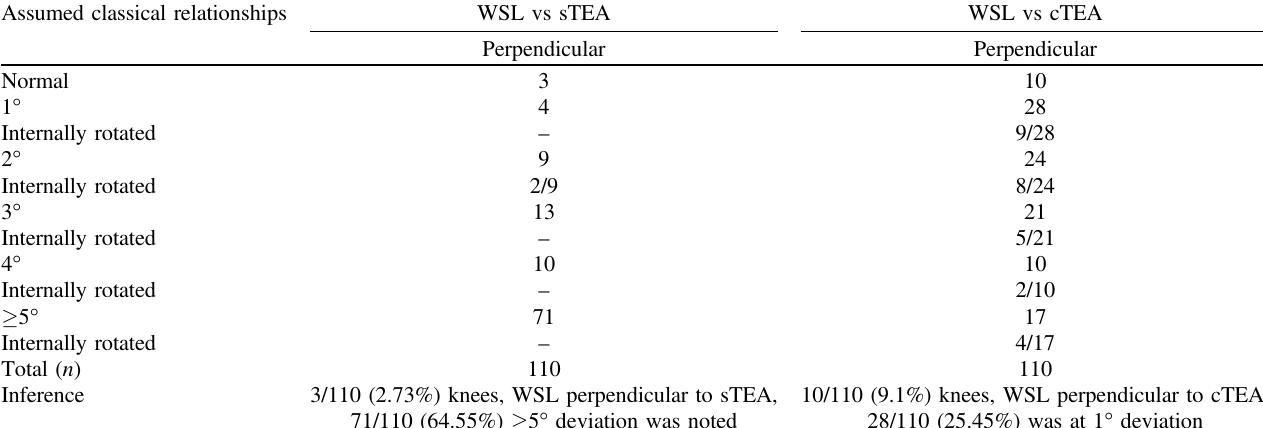
Table 4. Proportion of patients who vary from the assumed WSL to TEA relationship.